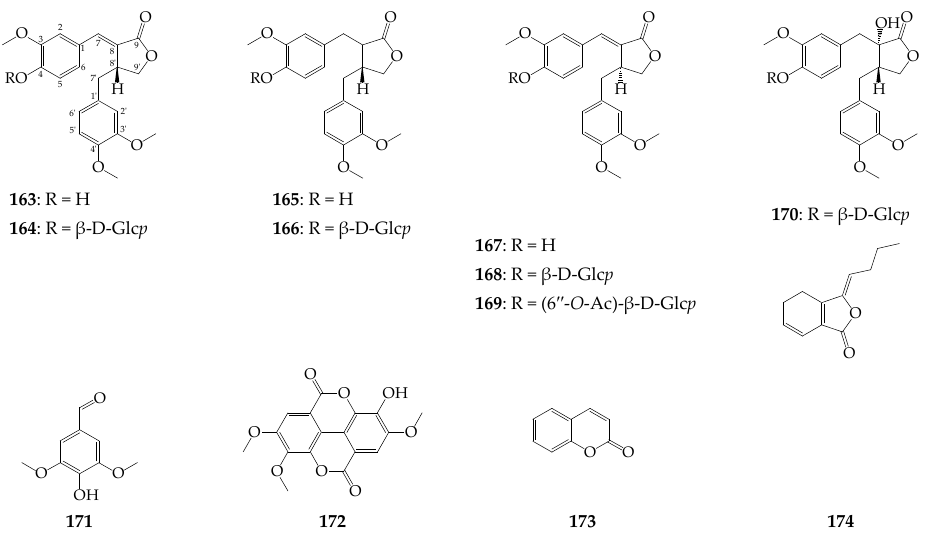
Figure 7 . Lignans 163 – 170 and various phenolics 171 – 174 . Ac– acetyl; β -D-Glc p – β -D- Figure 7. Lignans 163 – 170 and various phenolics 171 – 174 . Ac–acetyl; β -D-Glc p – β glucopyranose.